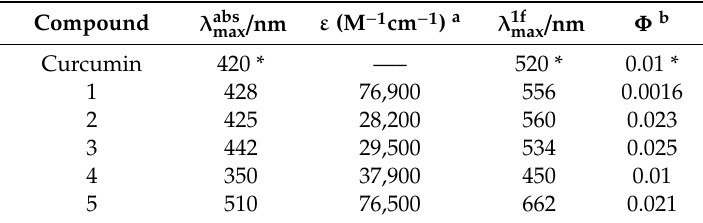
Table 2. Fluorescence properties of Compounds 1 – 5 and curcumin.